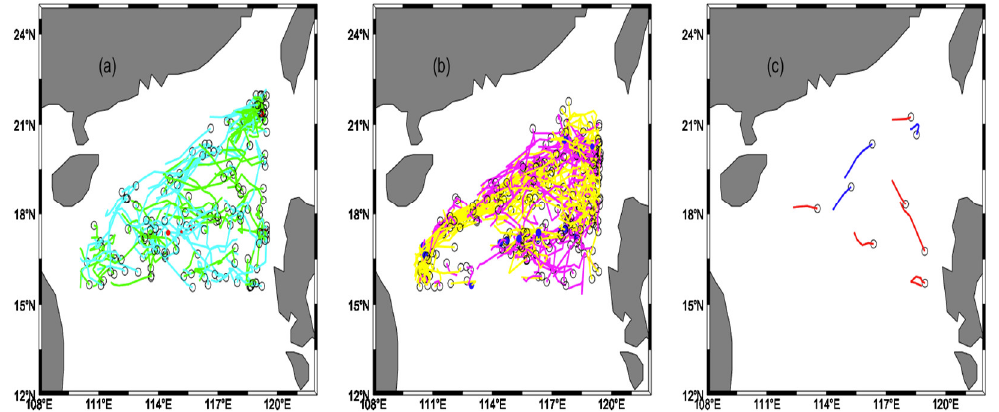
Figure 5. ( a ) The eddy trajectories of the anticyclonic eddy. Cyan trajectories are the eddy trajectories in winter. Green trajectories are the eddy trajectories in summer. ( b ) The eddy trajectories of the cyclonic eddy. Yellow trajectories are the eddy trajectories in winter; pink trajectories of the cyclonic eddies in summer; ( c ) eddy trajectories of the mode-water eddy. Blue trajectories are the trajectories of the mode-water eddy in winter, and red trajectories are the trajectories of the mode-water eddy in summer. China Sea, 177, 251, and 9 eddy trajectories of anticyclonic, cyclonic, and mode-water eddies corre- spond to 996, 1460, and 27 eddies, respectively. Among them, the numbers of anticyclonic eddies, cyclonic eddies, and mode-water eddies are 361, 420, and 5 in summer, respectively, and the numbers of anticyclonic eddies, cyclonic eddies, and mode-water eddies in winter are 635, 1040, and 22, respec- tively. The numbers of high nonlinear anticyclonic and cyclonic eddies are 12 and 21, respectively, and the mode-water eddies have no high nonlinear eddies. The numbers of low nonlinear anticyclonic, cyclonic, and mode-water eddies are 359, 610, and 12, respectively. The average eddy amplitudes of the anticyclonic eddy, cyclonic eddy, and mode-water eddy are 14.07 cm, 13.02 cm, and 13.09 cm, respectively. The average rotating speeds are 0.149 m/s, 0.138 m/s, and 0.159 m/s, respectively. The average transmission speeds are 0.058 m/s, 0.064 m/s, and 0.053 m/s, respectively. The average effective radii are 134.37 km, 136.43 km, and 126.28 km, respectively. The ratios of nonlinear mesoscale eddies (U/c > 1) to all eddies are 31.32%, 31.28%, and 27.91% of the total number of anticyclonic, cyclonic, and mode-water eddies, respectively. The average nonlinearities of anticyclonic, cyclonic, and mode-water eddies are 2.90, 2.77, and 1.49,